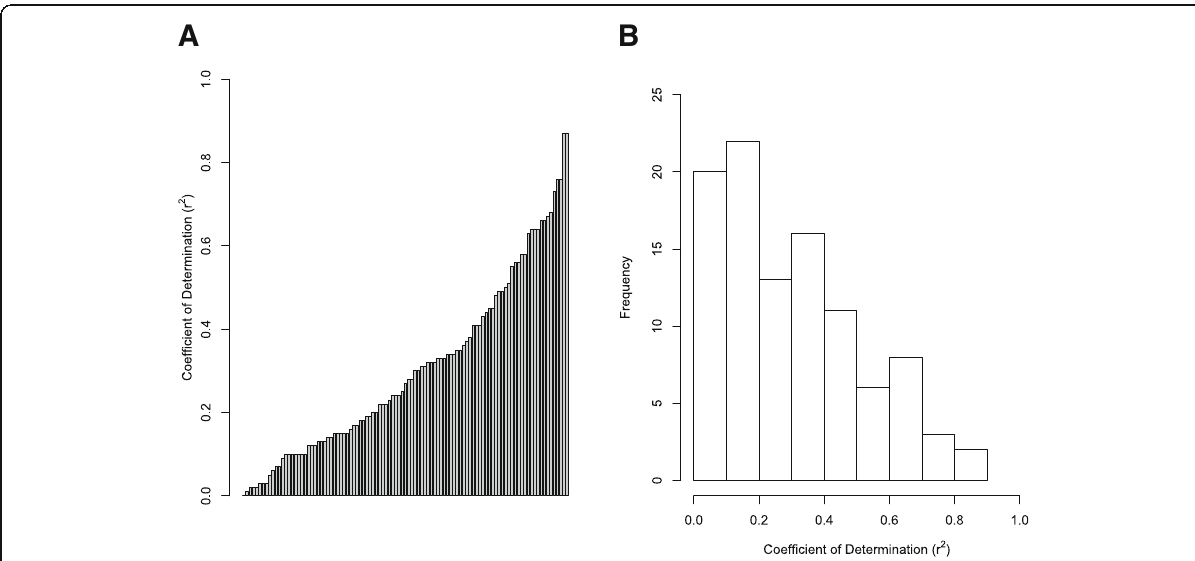
Fig. 1 Distribution of coefficient of determination values for tropical plant studies. a Range of coefficient of determination values taken from 33 studies (Additional file 1) that modeled growth rate of tropical plants with a single functional trait, either specific leaf area (SLA), leaf mass per area (LMA), leaf nitrogen content, leaf phosphorus content, wood density, or seed mass. b Frequency of coefficient of determination values for all studies